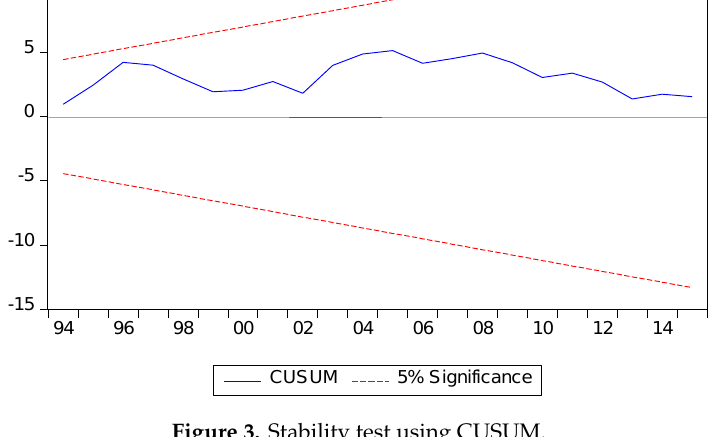
Figure 3. Stability test using CUSUM.